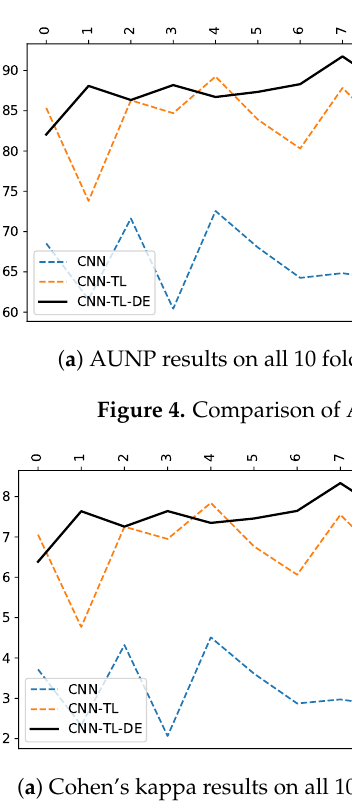
Figure 5. Comparison of Cohen’s kappa results for the compared methods over 10